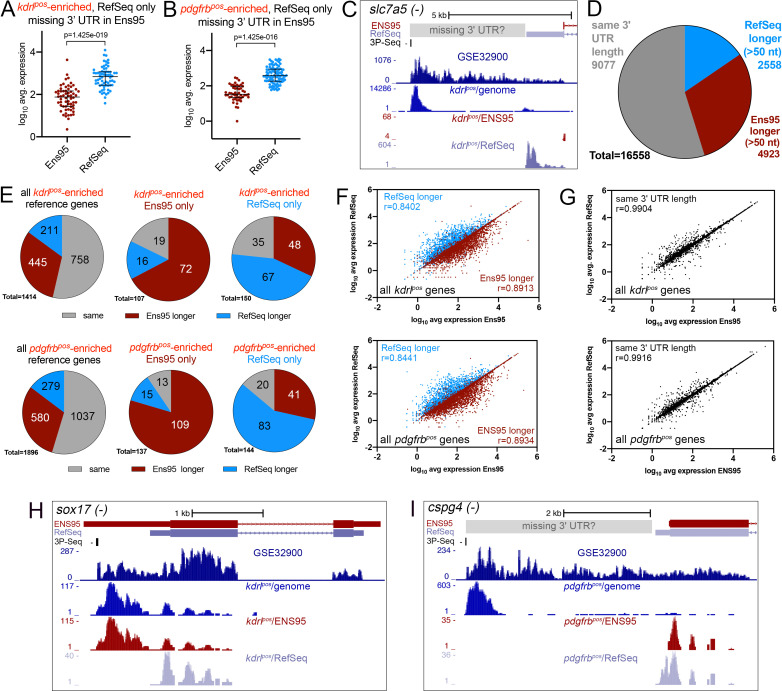
Incomplete 3' UTRs annotations contribute to discrepancies in RNA-seq analysis.(A, B) Log10 average expression as quantified using indicated annotation for (A) kdrlpos- or (B) pdgfrbpos-enriched genes identified as such only in RefSeq and lacking an Ens95 3' UTR annotation. Expression levels for genes from each annotation with matched NCBI ID are shown in each case. Data are normally distributed (Shapiro-Wilks test), paired t-test, p values are indicated; n = 3 (i.e. each point represents an average value from three separate RNA-seq replicates). (C) UCSC browser image of slc7a5 locus on the minus strand showing 3' UTR annotations from Ens95 and RefSeq. Mapped read depth from kdrlpos cells on the genome, or assigned to each annotation are indicated, as is a 3P-seq feature. The GSE32900 track is consolidated RNA-seq reads from all stages indicated in Figure 3A. The location of a putative missing 3' UTR is indicated. (D) Pie chart showing numbers of reference genes with the same or longer 3' UTRs in each indicated annotation. (E) Pie charts showing the proportion of reference genes selectively identified as kdrlpos- or pdgfrbpos-enriched by Ens95 and RefSeq with indicated relative 3' UTR length. (F, G) Correlation plots showing log10 average expression from kdrlpos RNA-seq (n = 3) quantified with each annotation for matched reference genes with (F) longer Ens95 (maroon) or RefSeq (light blue) 3' UTR, or (G) same 3' UTR length. Data are not normally distributed, Spearman correlation, r values are indicated. (H, I) UCSC browser images of (H) sox17 and (I) cspg4 loci, both on the minus strand, showing 3' UTR annotations from Ens95 and RefSeq. Mapped read depth of RNA-seq from (H) kdrlpos or (I) pdgfrbpos cells captured for each annotation is indicated. Consolidated reads from GSE32900 and location of 3P-Seq features are indicated, as is putative missing 3' UTR in cspg4.Figure 2—source data 1.Missing 3' UTR annotations in RefSeq and Ens95.This file includes lists of Ens95 (worksheet 1) and RefSeq (worksheet 2) genes indicating annotation as coding sequence (CDS) and whether there is an annotated stop codon and 3' UTR. Data from RNA-seq-based quantification for Ens95 genes missing a 3' UTR that is present in RefSeq is included for kdrlpos (worksheet 3), pdgfrbpos (worksheet 4), and Nr2f2pos (worksheet 5) cells. These data were used to generate Table 2 and graphs in Figure 2A,B; Figure 2—figure supplement 2I.Figure 2—source data 2.Reference gene set for 3' UTR comparisons.IDs for representative Ens95, RefSeq, and V4.3 transcript ID, along with V4.3 gene symbols are shown with respective 3' UTR lengths (worksheet 1). Average median ratio normalized expression and log2 fold change (pos/neg) values quantified with Ens95, RefSeq, and V4.3 annotations from kdrlpos (worksheet 2), pdgfrbpos (worksheet 3), and Nr2f2pos (worksheet 4) RNA-seq for reference genes are included. Data directly used to generate Figure 2D–G, Figure 2—figure supplement 2C–H, Figure 3B–J and incorporated into source data as indicated below.Figure 2—source data 3.RNA-seq analysis of Nr2f2pos and NR2f2neg cells.Output from DESeq2 analysis comparing Nr2f2pos and Nr2f2neg RNA-seq from gene expression levels quantified using RSEM with Ens95 (worksheet 1) or RefSeq (worksheet 2). Median ratio normalized expression values are shown for each sample, along with adjusted p-value, p-value, log2 fold change, fold change, and log10 adjusted p-value. Intersection of genesets identified as significantly enriched in Nr2f2pos cells using Ens95 or RefSeq (worksheet 3).Figure 2—source data 4.Transcript based-comparison of RefSeq and Ensembl annotations.Worksheet one is a list of Ens95 genes missing from RefSeq with Ensembl gene ID, matching ZFIN ID and biotype annotation. Worksheet two is a list of RefSeq genes missing from Ensembl with NCBI gene ID, matching ZFIN ID, and coding sequence annotation. Transcript level matching output from gffcompare is included using Ens95 (worksheet 3) or RefSeq (worksheet 4) as a reference. Worksheet five is a transcript level comparison of Ens95 and Ens99. In this case, all transcripts exhibit a complete intron/exon chain match (designated by a ‘=" in class code). Data used to generate Table 3.